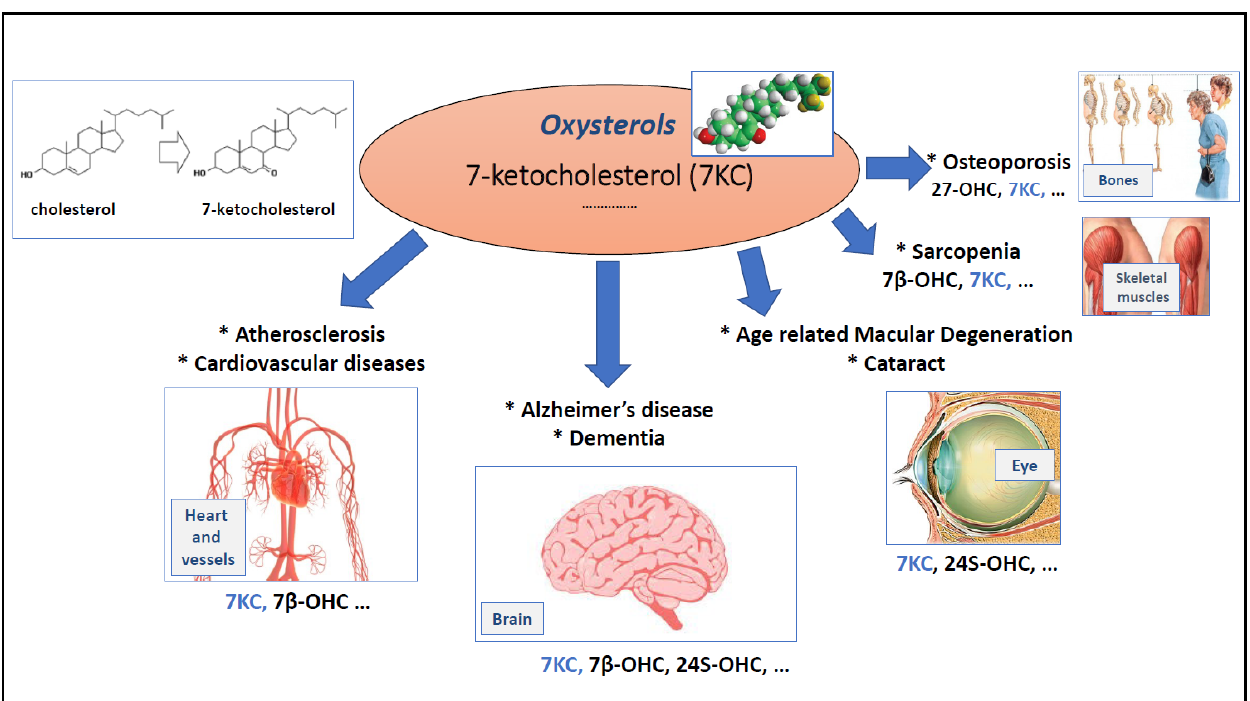
Figure 1. Involvement of 7-ketocholesterol (7KC) in age-related diseases [6]. The presented scheme is based on in vitro and/or in vivo proofs of concept.